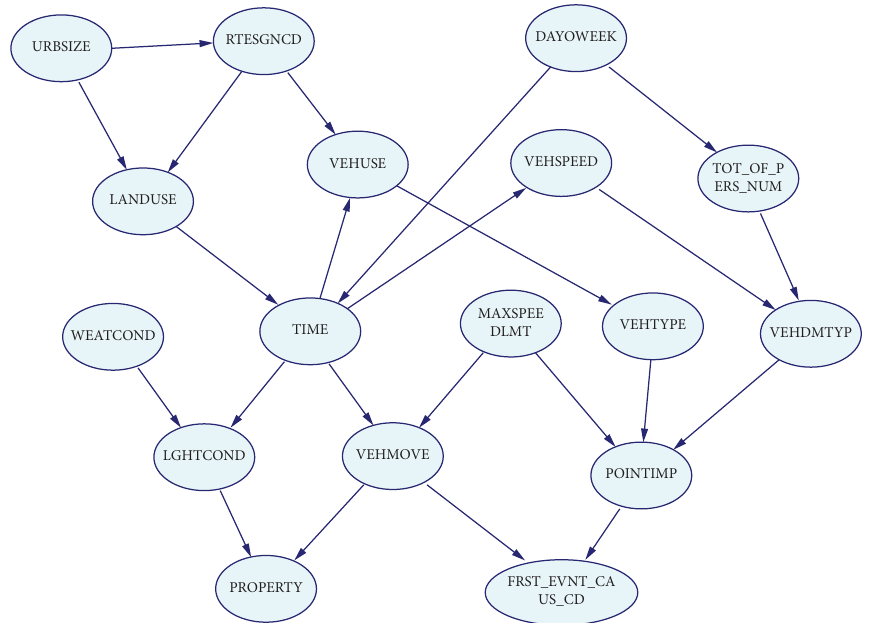
Figure 3: Bayesian network model for parking lot accidents.